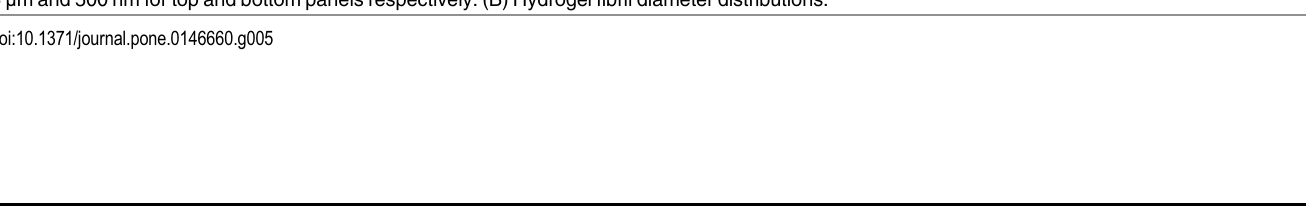
Fig 5. Freezing-induced morphological changes in collagen hydrogels at network and fibril levels. (A) Representative SEM images. Scale bars are 5 μ m and 500 nm for top and bottom panels respectively. (B) Hydrogel fibril diameter